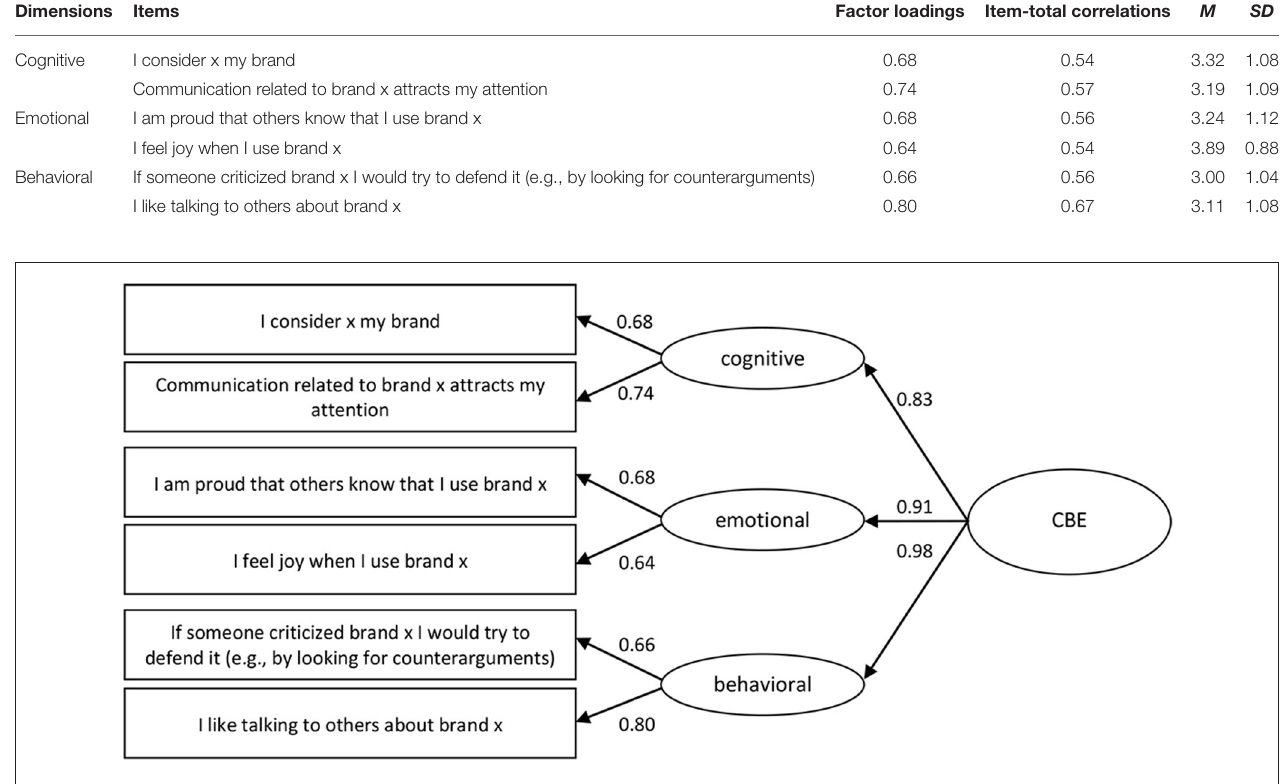
FIGURE 2 | The higher order model of CBE (Study 1).